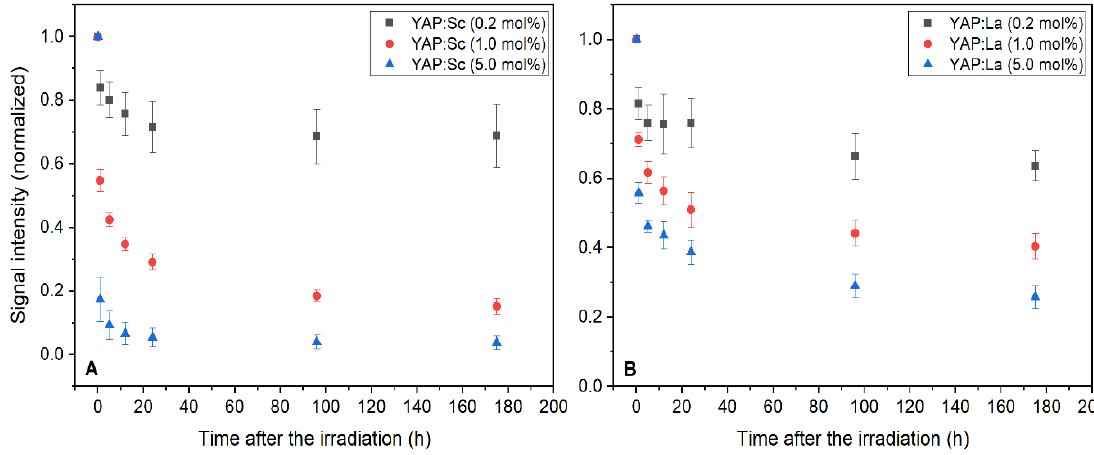
Figure 7. Fading analysis for the studied YAP crystal samples doped with Sc ( A ) and La ( B ).